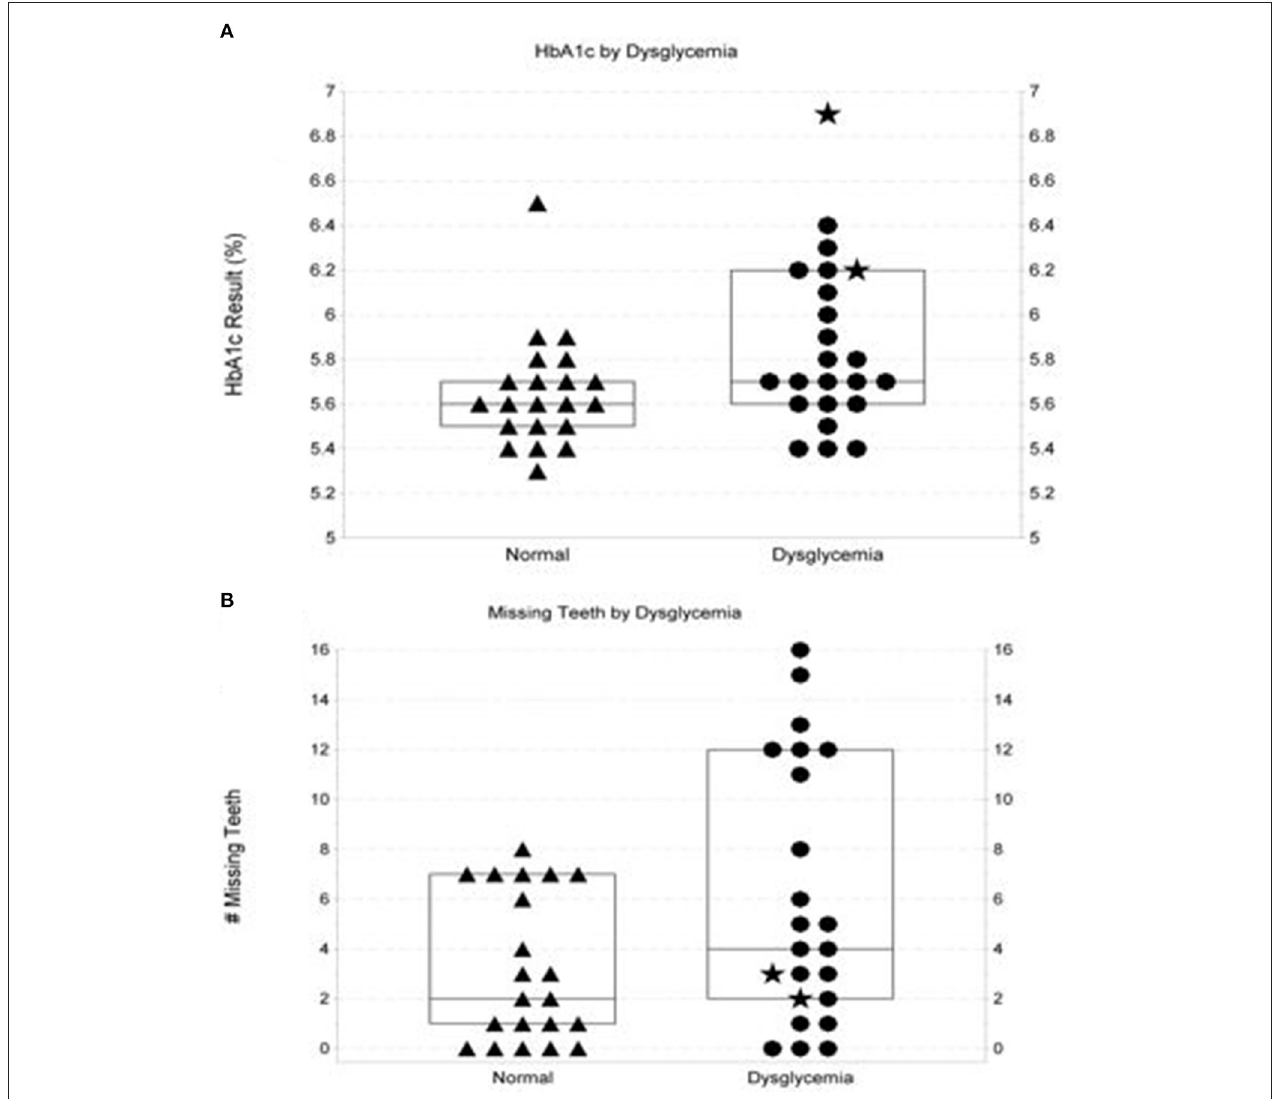
FIGURE 2 | Characteristics of at-risk dental patients with normo-glycemic point-of-care screening outcomes vs. those with outcomes in the pre-diabetic/diabetic range. (A) shows distribution of follow-up glycemic measures performed by a commercial laboratory in the medical setting on at-risk patients with normoglycemic vs. elevated glycemic measures when screened at point-of-care. Box plot in (A) show the median and interquartile range. Two patients screening in the diabetic range are denoted by ⋆ . The figure shows a trend ( p = 0.054) for more follow-up measures in hyperglycemic ranges (defined as HbA1c measures ≥ 5.7% or fasting plasma glucose measures ≥ 100 mg/dL. (B) illustrates observations surrounding numbers of missing teeth documented in at-risk patients with initial elevated HbA1c screening measures ( ≥ 5.7%) vs. number of missing teeth in those with point-of-care HbA1c measures in the normoglycemic range ( p -value = 0.094). Box plots in (B) show the median and interquartile range. Two patients screening in the diabetic range are denoted by ⋆